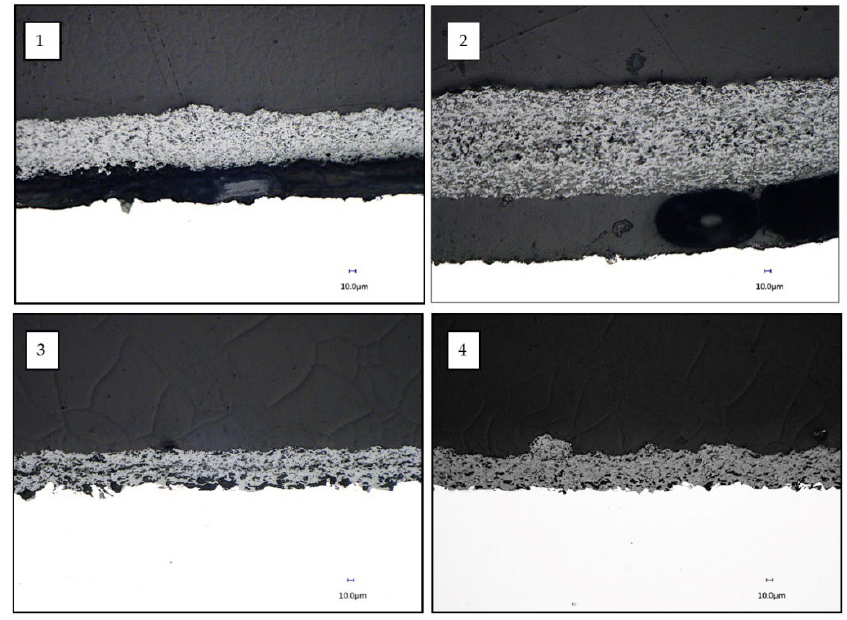
Figure 3. Optical microscope images of the cross-sections of samples 1 , 2 , 3, and 4 sprayed for the optimization process according to Table 2.